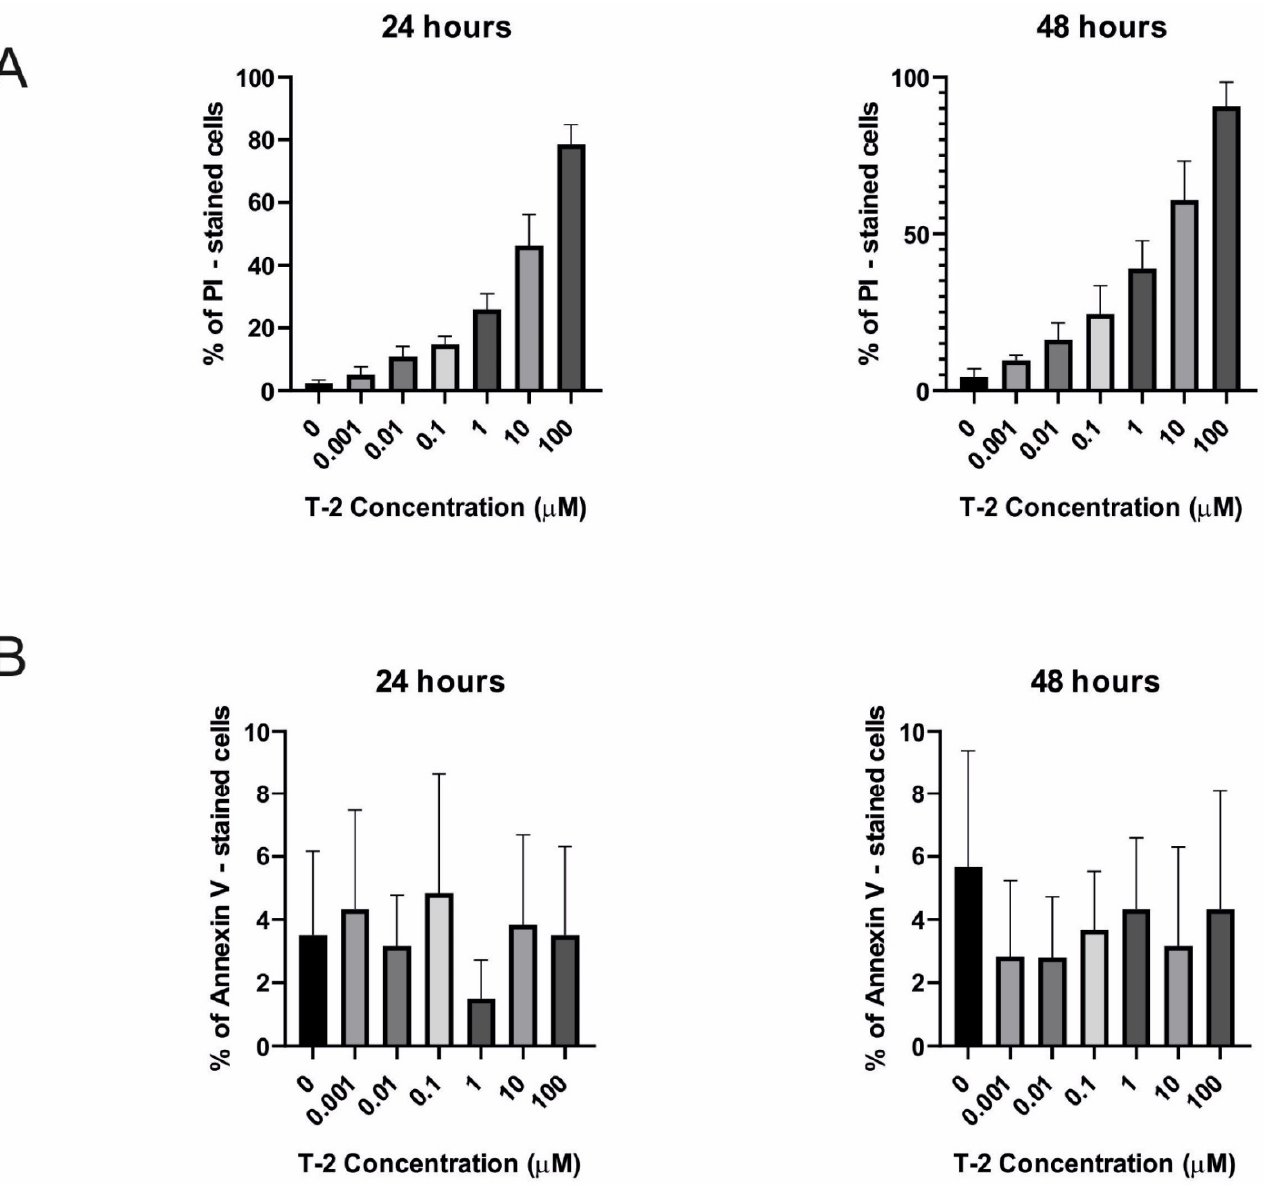
Figure 4. The T-2 effect on necrosis and apoptosis induction in Hs68 cells. The cell death pathway was assayed by flow cytometry with annexin V/propidium iodide staining after 24 h ( A ) and 48 h ( B ) of incubation with the toxin. Values: means ± SD ( n = 6). 0: untreated (control) cells; 0.001: concentration of toxin—0.001 µM; 0.01: concentration of toxin—0.01 µM; 0.1: concentration of toxin— 0.1 µM; 1: concentration of toxin—1 µM; 10: concentration of toxin—10 µM; 100: concentration of toxin—100 µM.